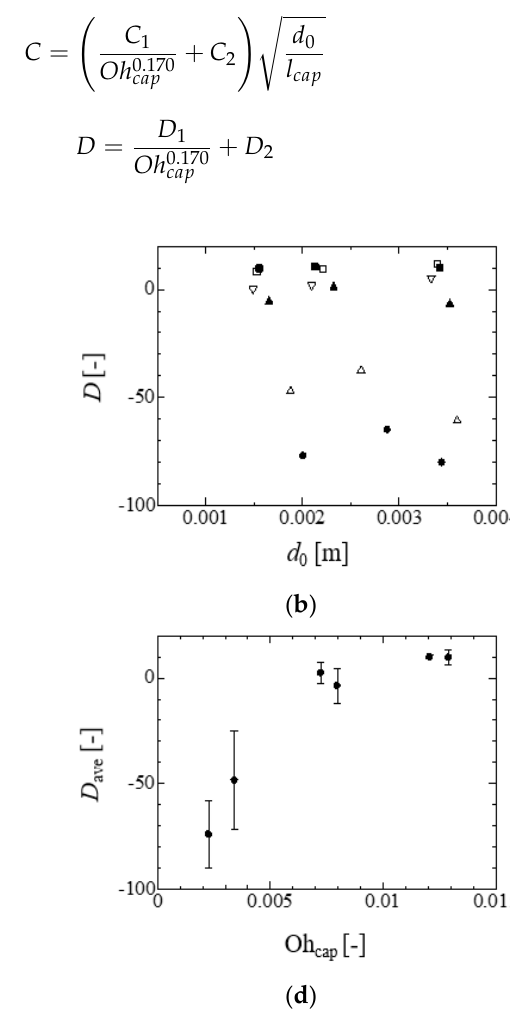
Figure 10. Coefficients C and D in Equation (4): size dependences in ( a ) C /( d *) 1/2 and ( b ) D ; Oh cap dependences in ( c ) averaged C /( d *) 1/2 and ( d ) averaged D where each value is averaged among droplet sizes. The error indicates two standard deviation (2SD).